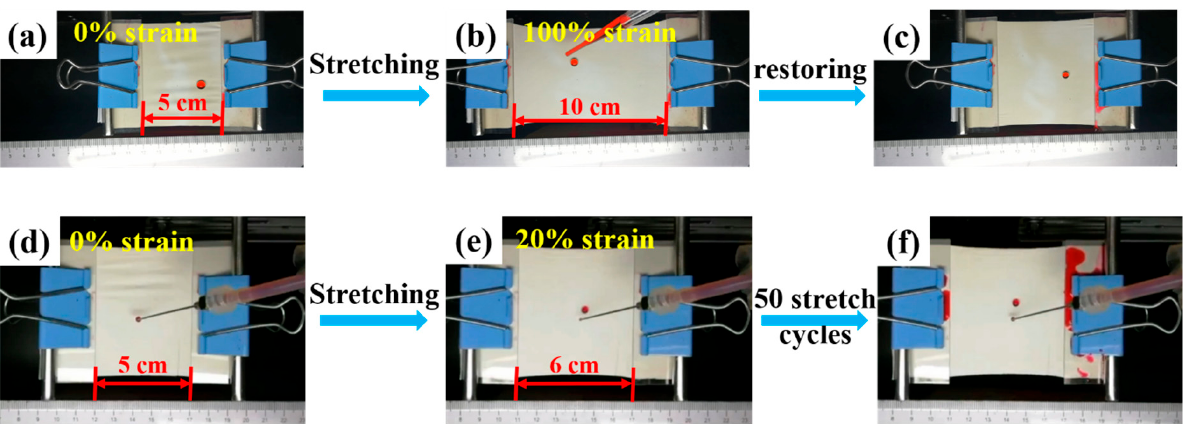
Figure 7. Hydrophobicity of the SBS/PDA/SiO 2 fibrous membrane during dynamic tensile deformations with ( a ) 0% strain, ( b ) 100% strain, and ( c ) 0% strain in a cycle and ( d ) 0% strain and ( e ) 20% strain in a cycle and ( f ) after 50 stretch cycles of 0–20% strain.